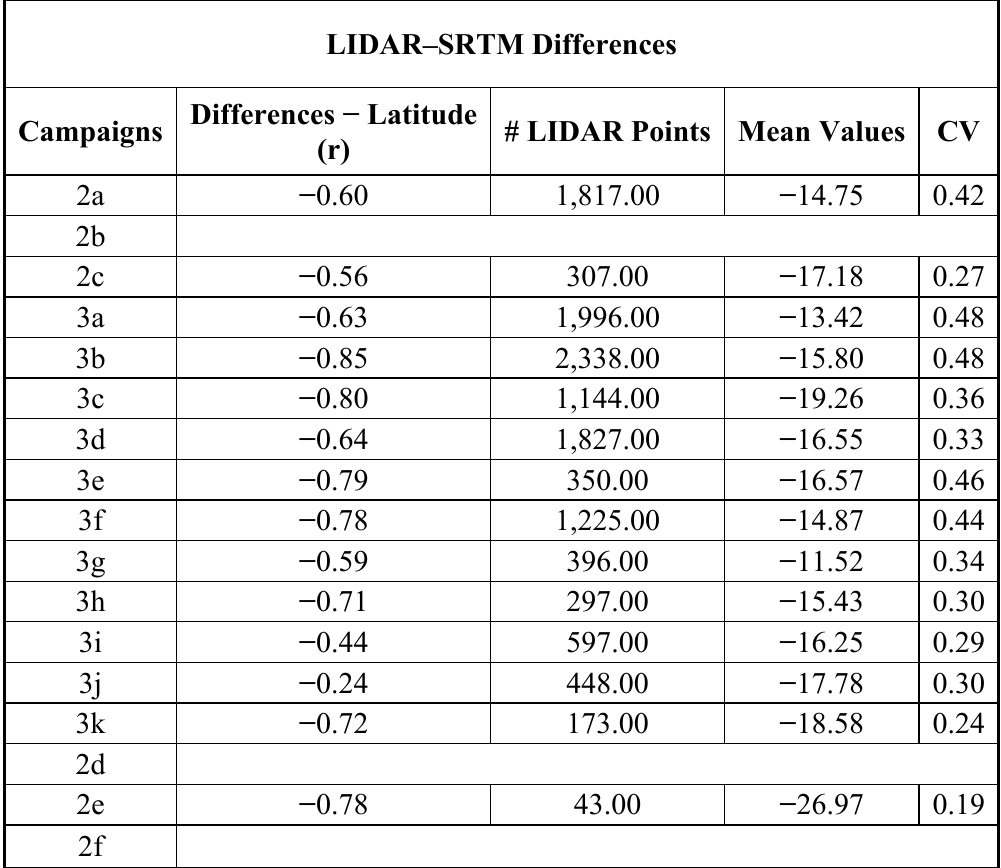
Table 2. Differences between elevation retrievals from GLAS LIDAR and SRTM data. LIDAR–SRTM